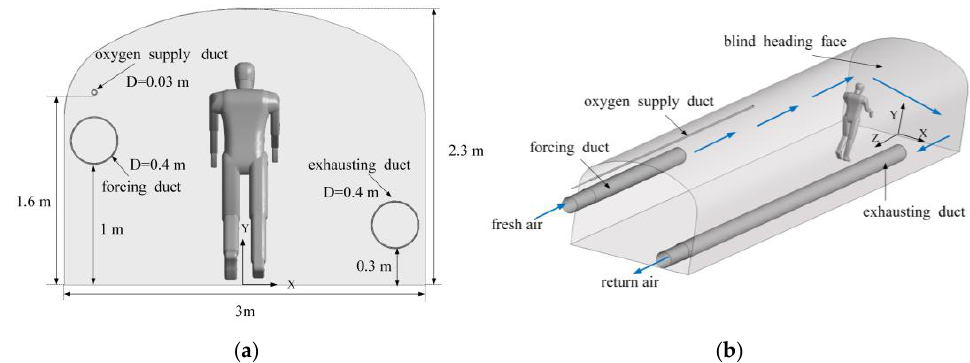
Figure 2. Geometric model of the roadway. ( a ) Cross-sectional size of the roadway; ( b ) three- dimensional model of the roadway.